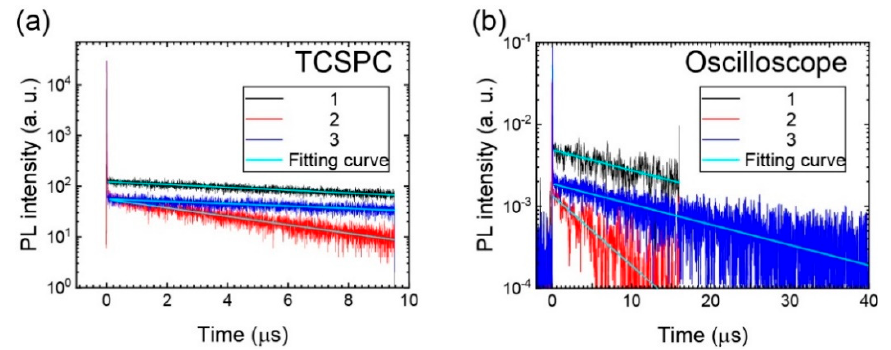
Figure 5. RTP lifetime measurements of 1 − 3 in solutions after N 2 purging using ( a ) time-correlated single photon countering (TCSPC) (excitation wavelength: 342 nm) and ( b ) 12-bit oscilloscope (excitation wavelength: 355 nm).